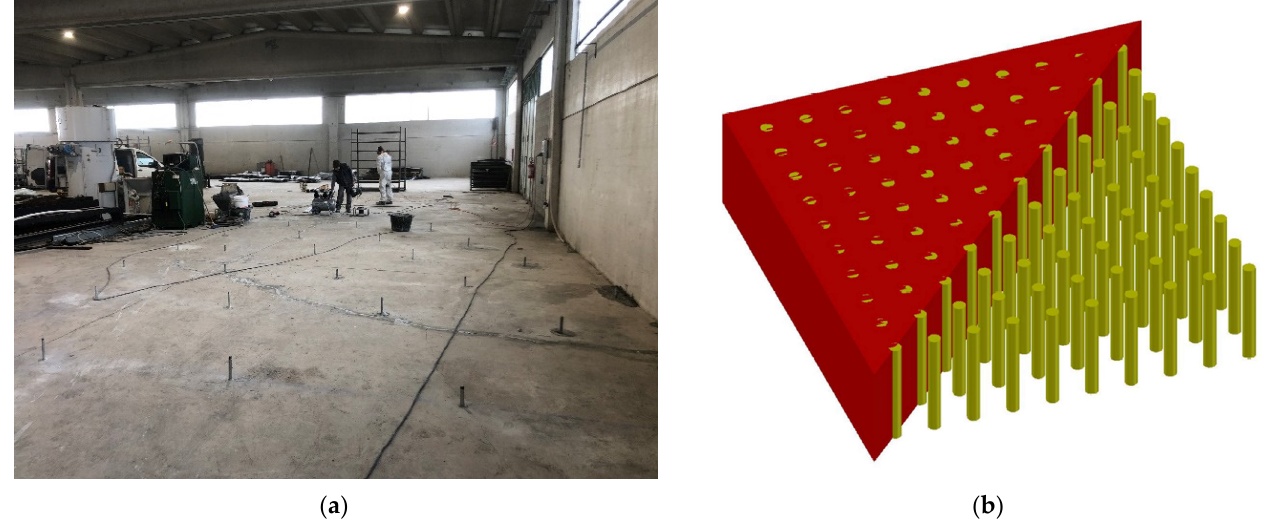
Figure 1. Polyurethane injection scheme underneath foundation slabs: ( a ) Application example realised by Bequadro S.r.l., and ( b ) schematisation of polyurethane injections as cylinders (green) in the soil matrix (red).